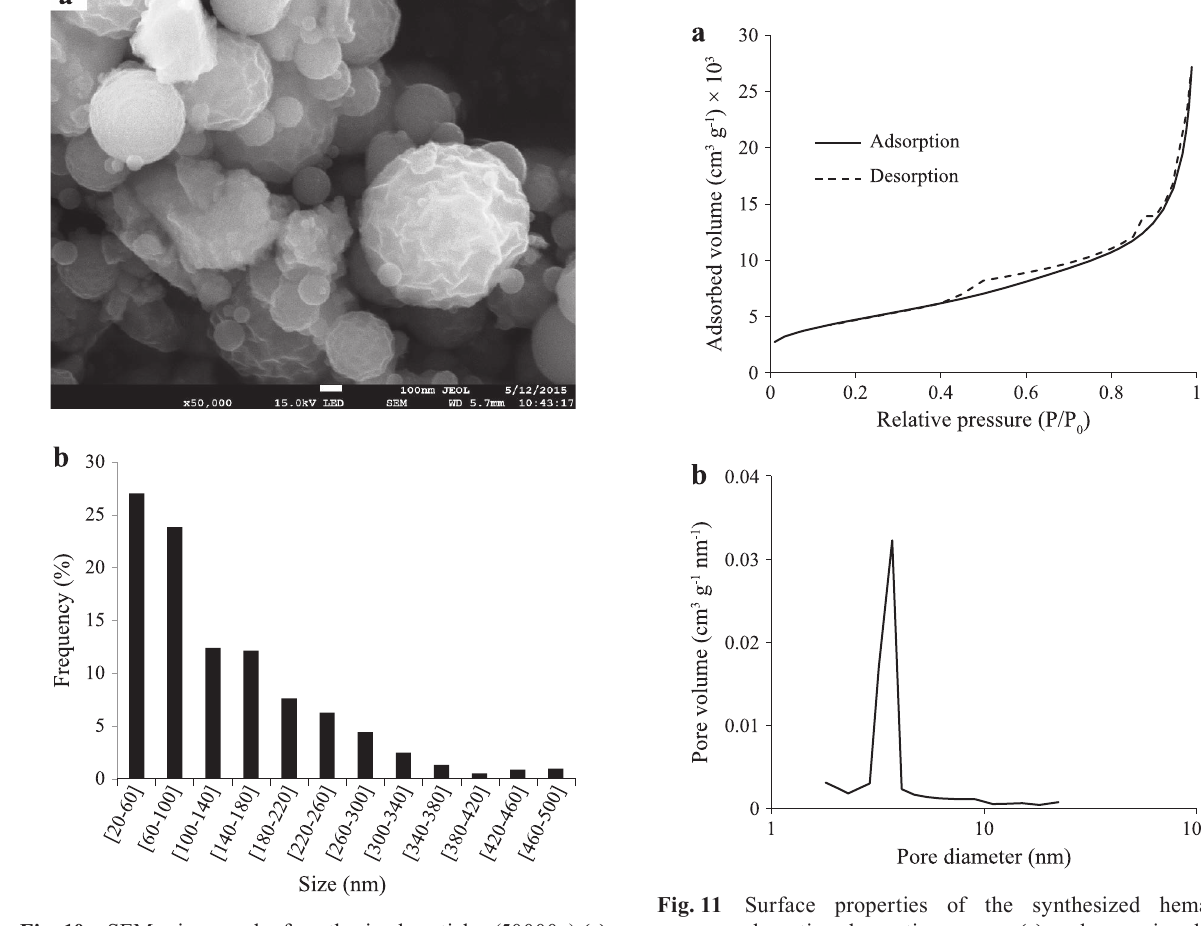
Fig. 10 SEM micrograph of synthesized particles (50000×) (a) and size distribution of the elementary particles (b) .